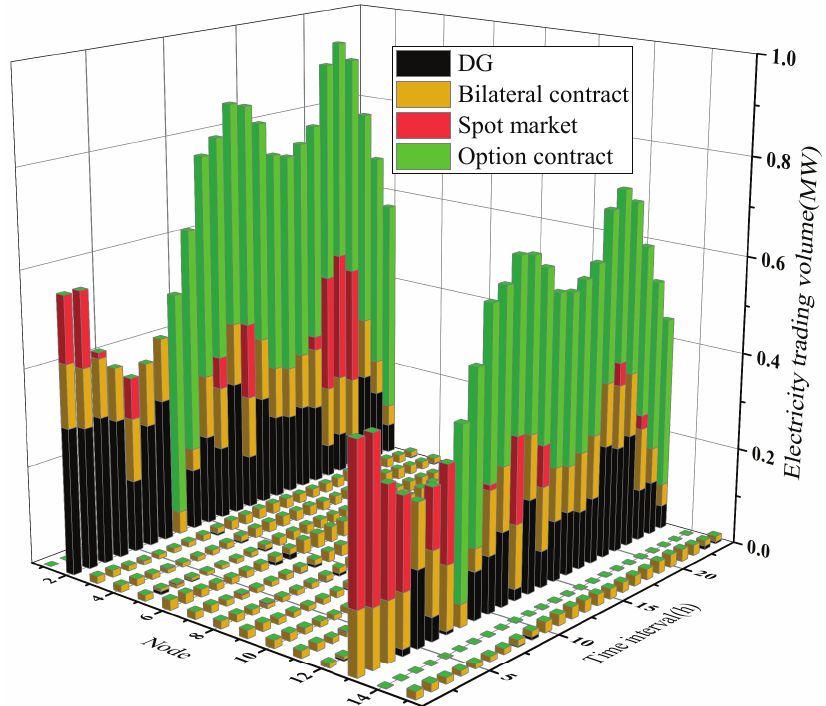
Figure 6. Electricity transaction strategy when the risk aversion factor is